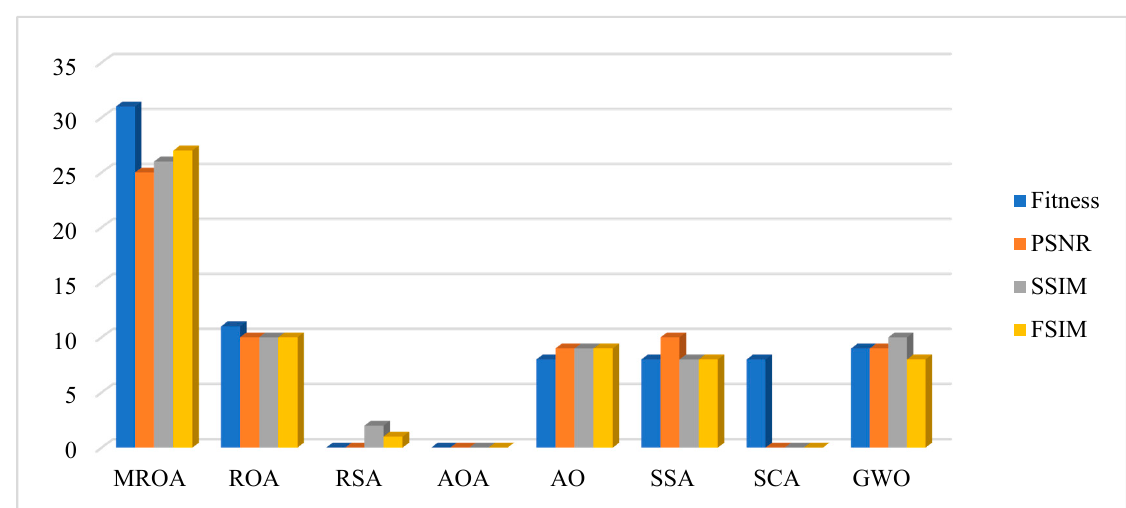
Figure 13. Average FSIM values obtained by the algorithms over all images.